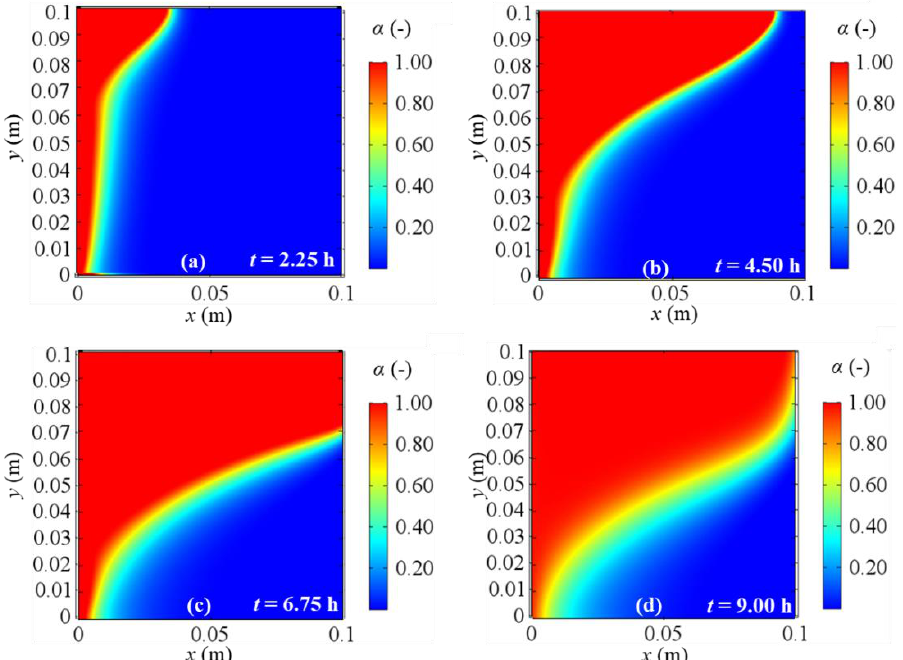
Figure 17. Melting fraction evolution for a 2D model with natural convection and BC 4 at different evaluation times: ( a ) after 2.25 h; ( b ) after 4.50 h; ( c ) after 6.75 h; ( d ) after 9.00 h from the simulation beginning respectively.